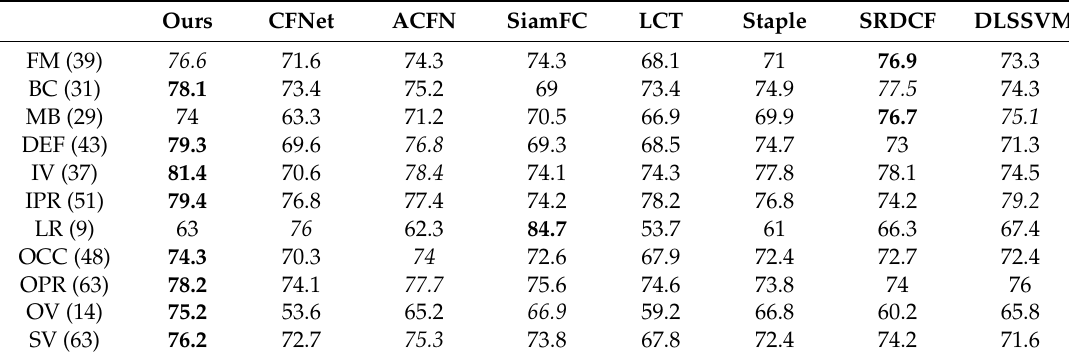
Table 5. Distance precision rate (%) of 11 di ff erent attributes on OTB2015 dataset.